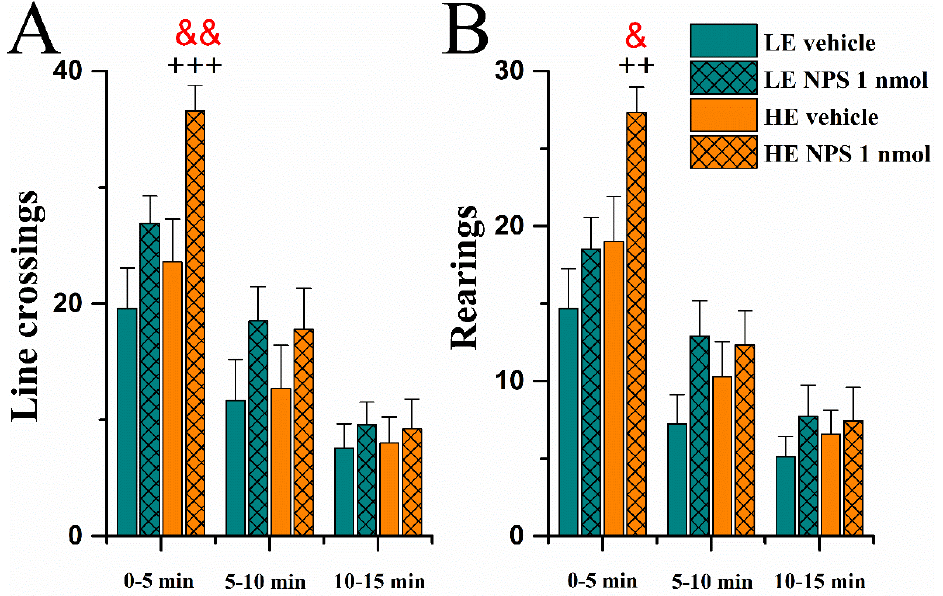
Figure 9. Locomotor activity in a novel large rat cage approximately 1 h after vehicle /NPS (1 nmol, i.c.v.) administration: line crossings ( A ) and rearings ( B ) (data shown as mean ± SEM). &, &&: p < 0.05, 0.01 vs. HE vehicle, respectively; ++, +++: p < 0.01, 0.001 vs. LE NPS, respectively. Red colour denotes difference from respective vehicle group. HE: high exploring rats; LE: low exploring rats; NPS: neuropeptide S. HE vehicle ( n = 7); HE NPS ( n = 9); LE R vehicle ( n = 10); LE NPS ( n = 10). Number of USVs